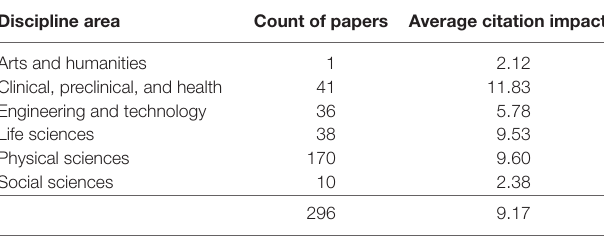
TaBle 3 | UK papers with 20 or more collaborating countries, grouped by discipline area. Discipline